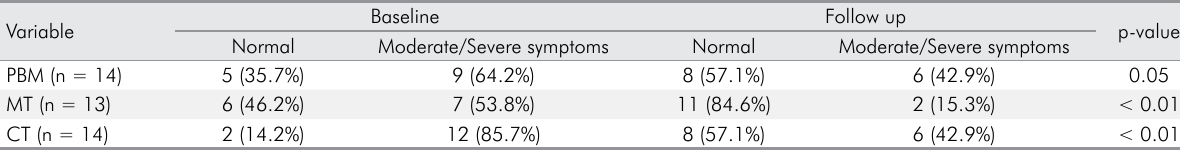
Table 7. RDC axis II: Assessment of D3b nonspecific physical symptoms without pain). Variable